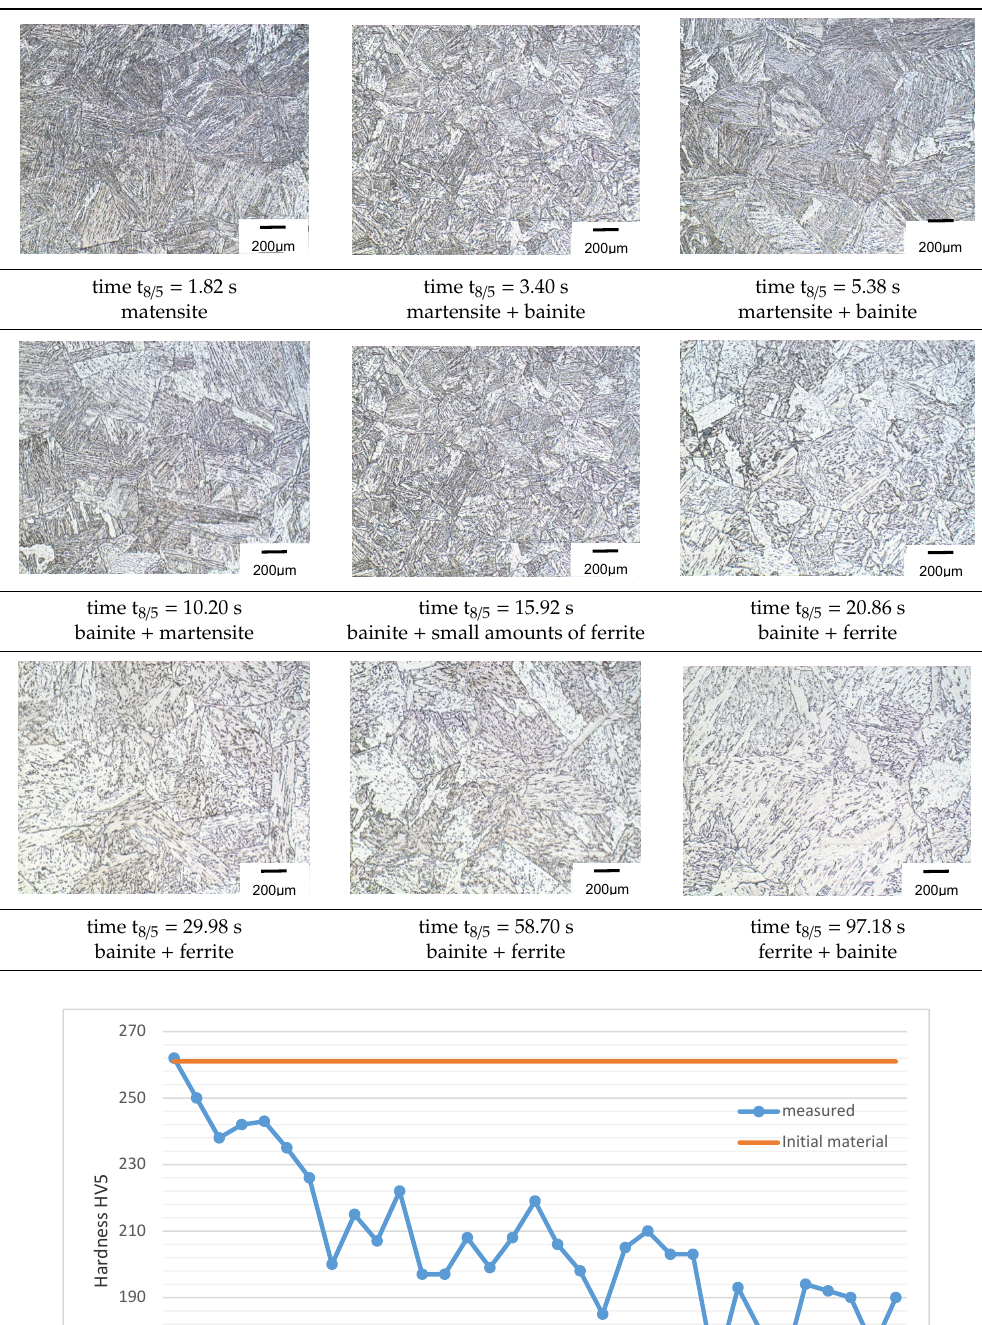
Table 7. The microstructure of HAZ of S700MC steel as a function of cooling time t 8/5 for a cycle of the maximum temperature about 1250 °C.